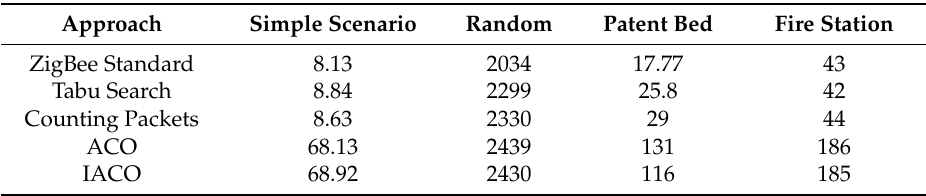
Table 24. Management Traffic